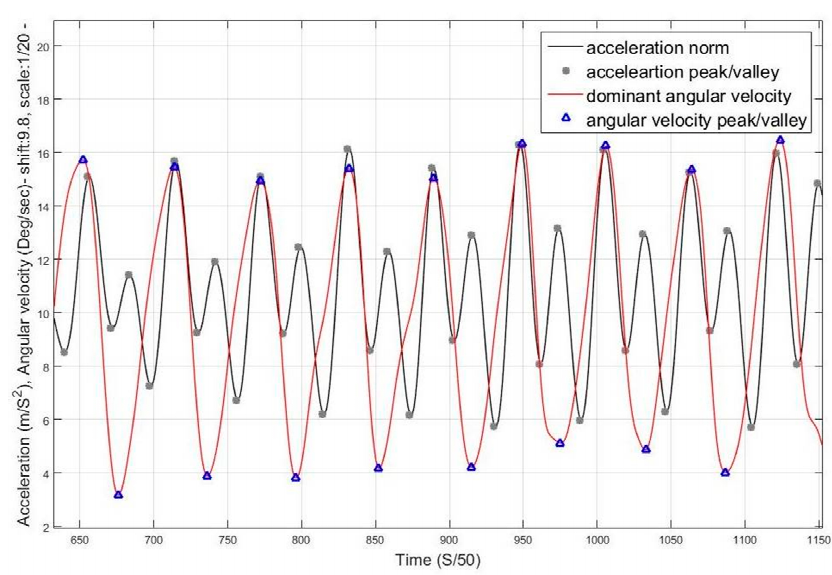
Figure 11. Peak matching between acceleration norm and dominant angular rate.